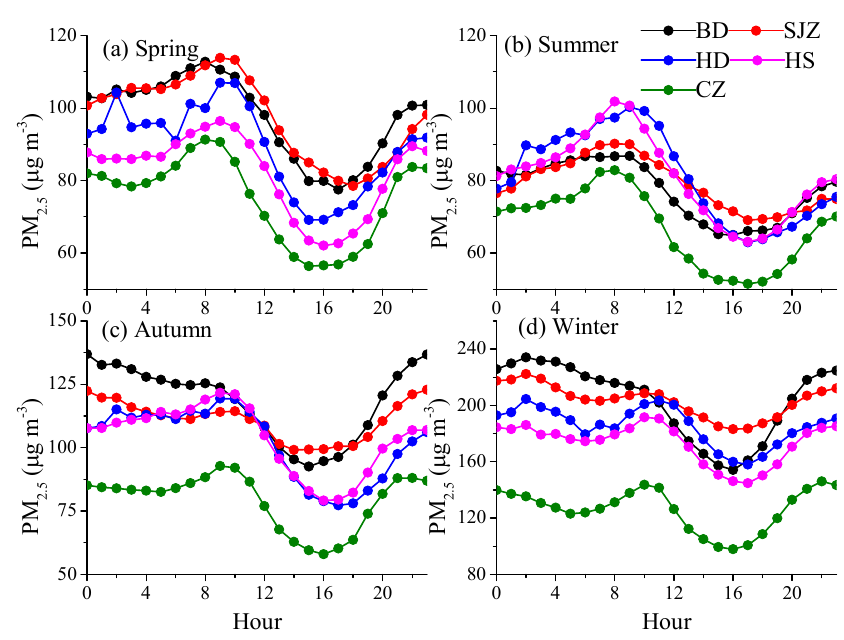
Figure 6. Statistic diurnal variation of PM 2.5 for the four seasons ( a -spring, b -summer, c -autumn, d -winter) in five cities during 2013–2015.